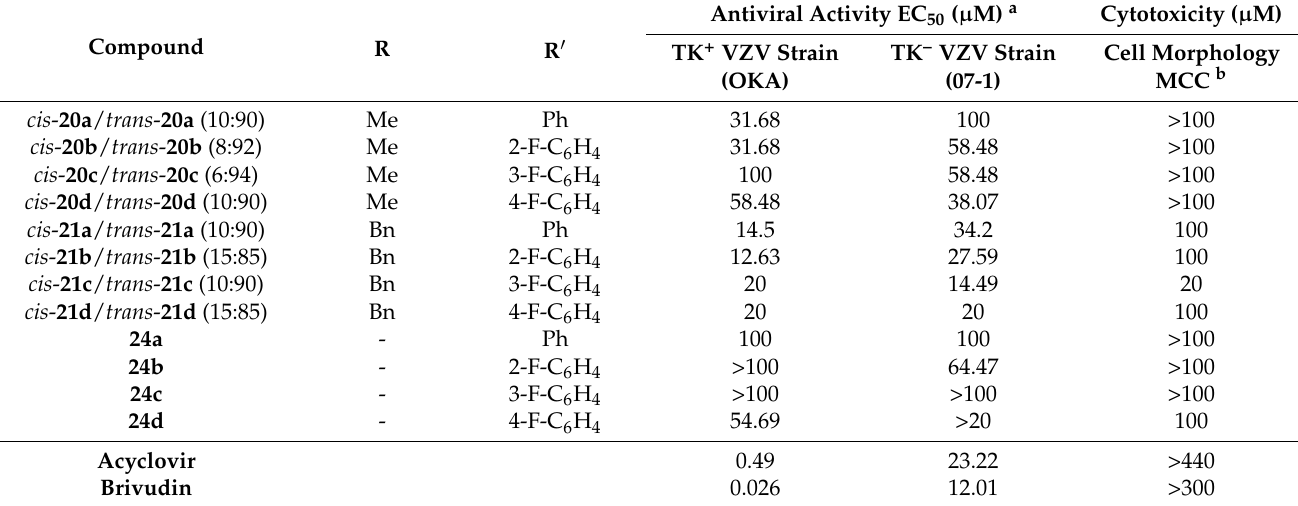
Table 2. Antiviral activity and cytotoxicity against varicella-zoster virus (VZV) in HEL cell